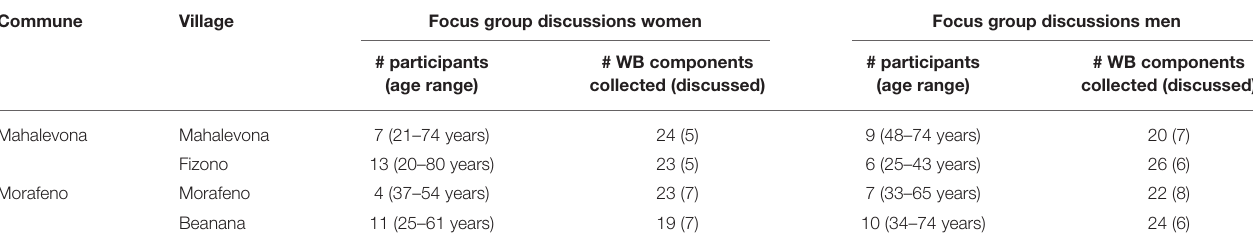
TABLE 2 | Focus group discussions’